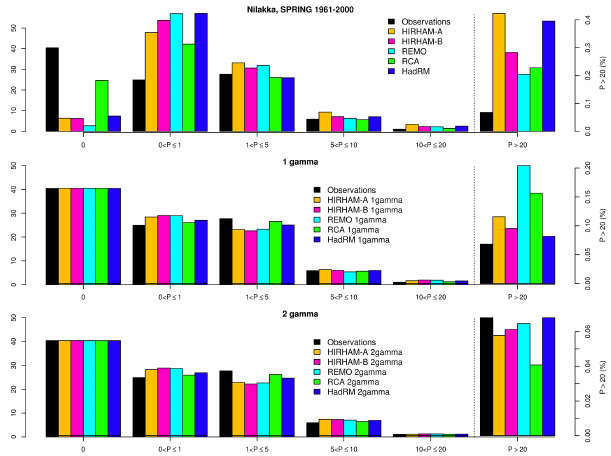
Figure 6. Distribution of daily precipitation amounts during the control period 1961–2000 spring in Nilakka catchment in obser- vations and uncorrected RCM data (top panel), single Gamma- adjusted RCM data (middle panel) and double Gamma-adjusted RCM data (bottom panel). Notice the uneven precipitation divi- sion and different scaling for precipitation amounts greater than 20mmday − 1